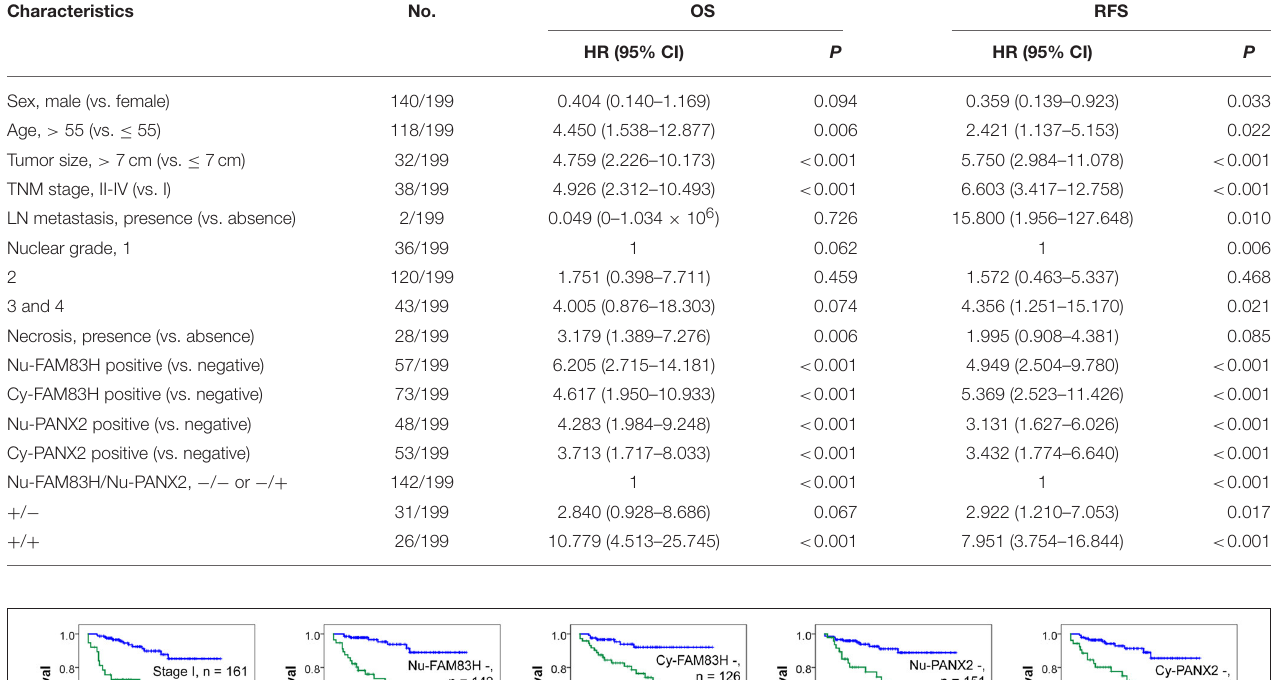
TABLE 3 | Univariate Cox proportional hazards regression analysis for the overall survival and relapse-free survival of clear cell renal cell carcinomas. Characteristics